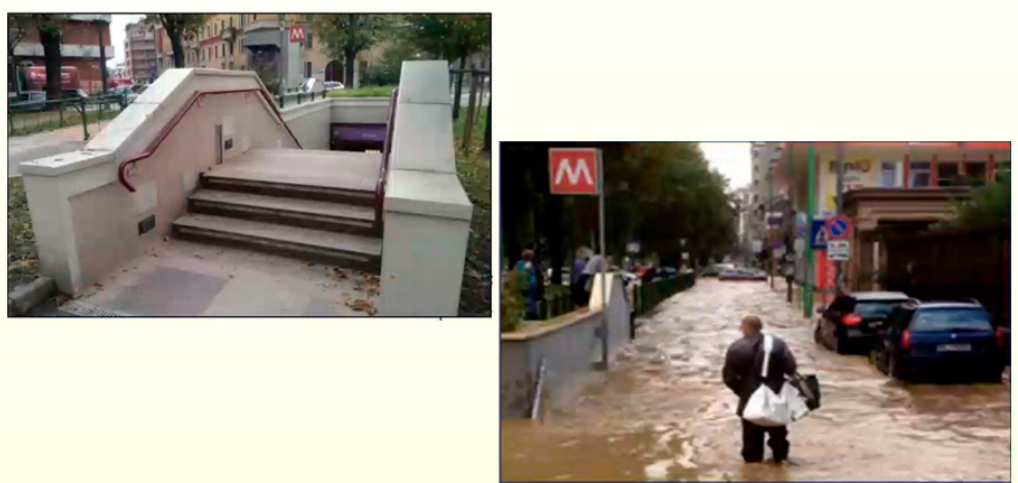
Figure 8. Example of water proofing intervention: ( left ) raised elevation of the contour of the access facility to a Metro MM5 station in Milan; ( right ) the same access proving to impede water entrance into the station, while keeping its full functionality, during a harsh flood from Seveso river in 2014 (by kind permission of Daniele Bignami, Politecnico di Milano, FLORIMAP project, Fondazione Cariplo, Milano, I).